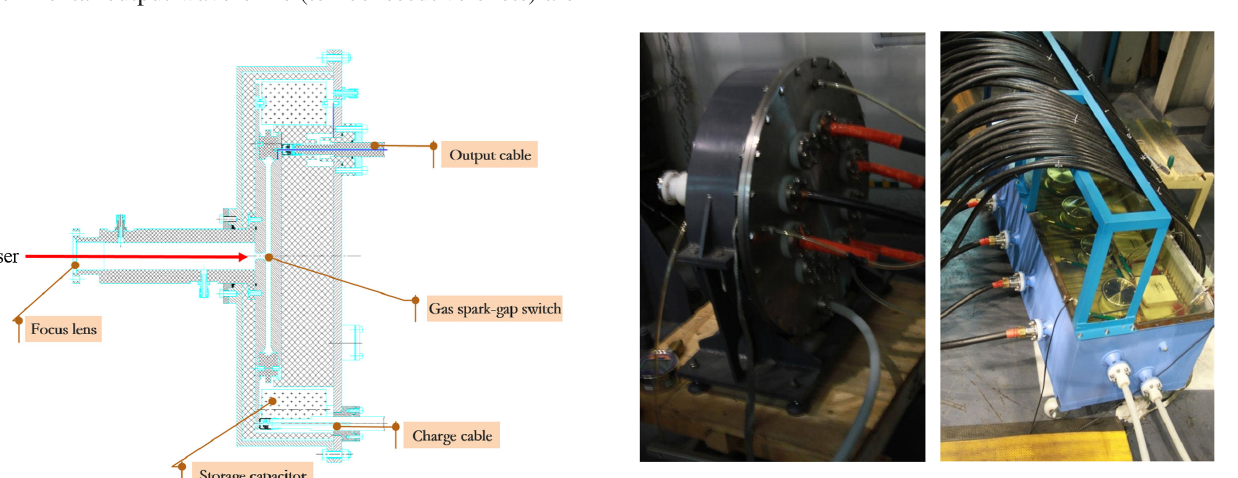
FIG. 14. Configuration of the former-trigger unit.